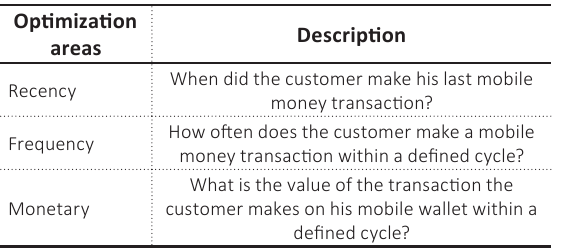
Table 2. The research approach for target